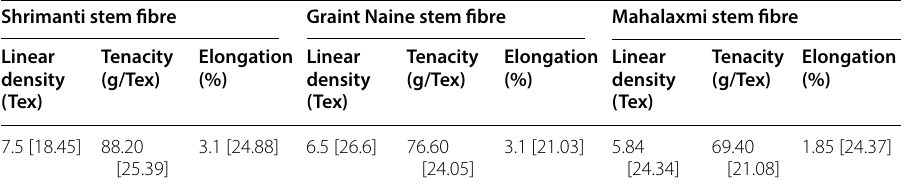
Values in bracket indicate C.V. %